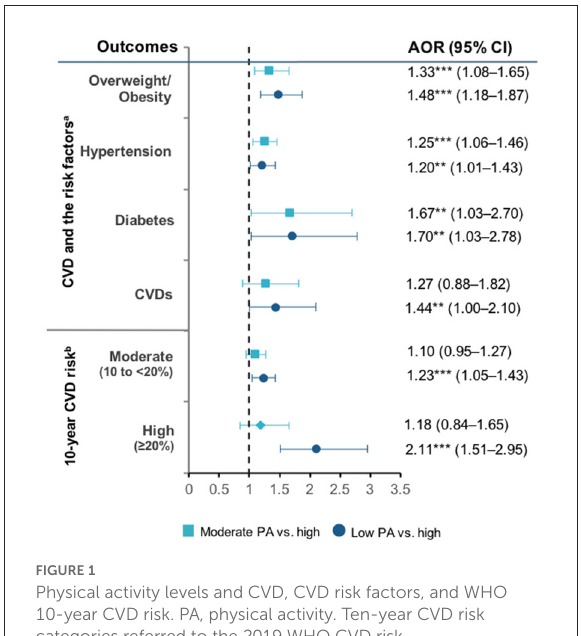
FIGURE1 Physical activity levels and CVD, CVD risk factors, and WHO 10-year CVD risk. PA, physical activity. Ten-year CVD risk categories referred to the 2019 WHO CVD risk non-laboratory-based charts (Southeast Asia) that consider age, tobacco use, gender, systolic blood pressure, and BMI to derive the risk categories.